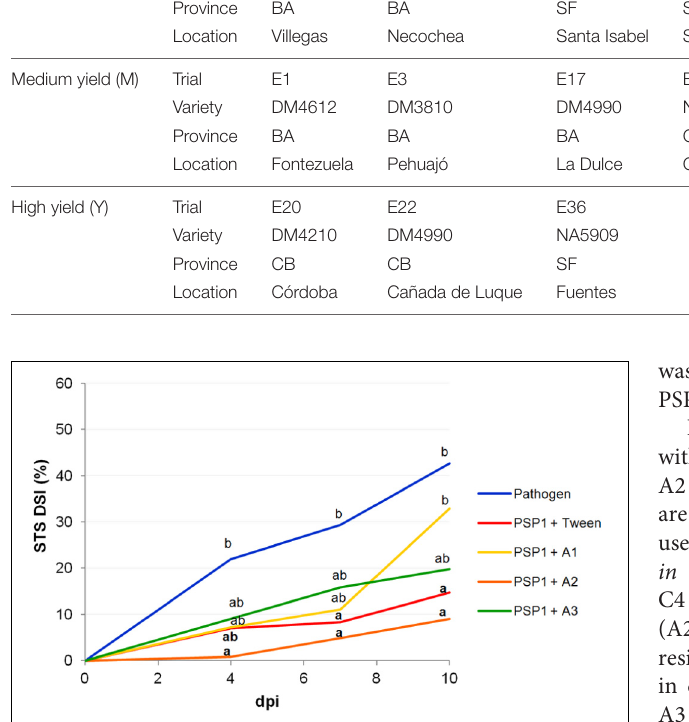
FIGURE 1 | Effect of surfactant adjuvants on the defense-eliciting activity of PSP1 against C. cassiicola in soybean. Aqueous solutions of PSP1 (0.5 U ml − 1 ), combined with Tween 20, A1 [nonylphenol ethoxylates (NPEs) + chelating and acidifying agents], A2 (NPEs + silicone and